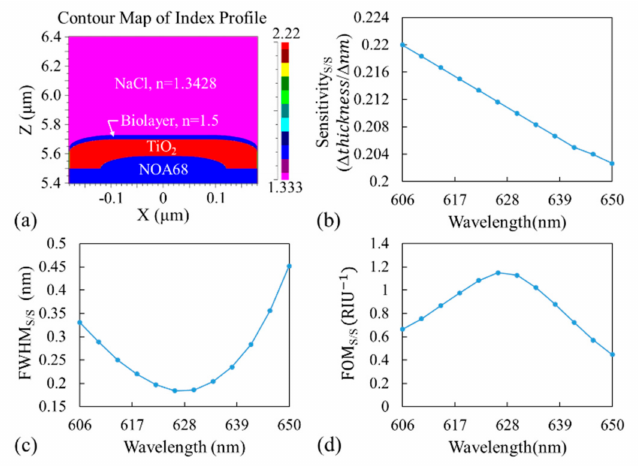
Figure 3. ( a ) Cross-section of one period of the simulated model with an additional biolayer on top of TiO 2 to simulate biomolecule adsorption. ( b ) Sensitivity S/S , ( c ) FWHM S/S , and ( d ) FOM S/S as a function of incident wavelength. Here, the subscript S/S indicates simulation results (S) obtained with the surface-adsorbed layer